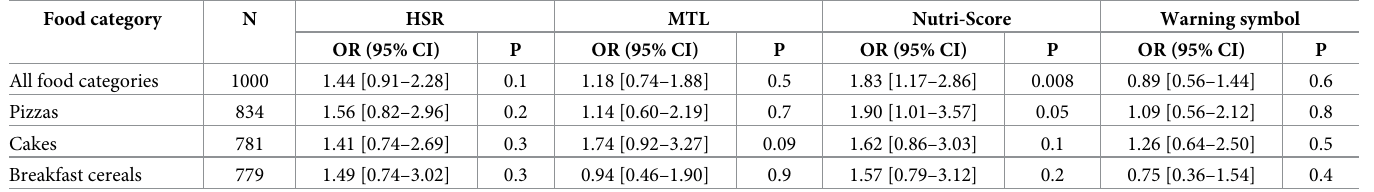
Table 2. Associations between FoPL type and change in nutritional quality of food choices, by FoPL type and food category in participants who made a choice a (N = 1,000). Food category